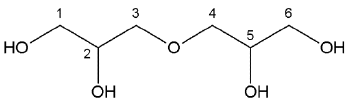
Structure no. 1. Diglycerol (M = 166g/mol) Structure no. 2. Triglycerol (M = 240g/mol)